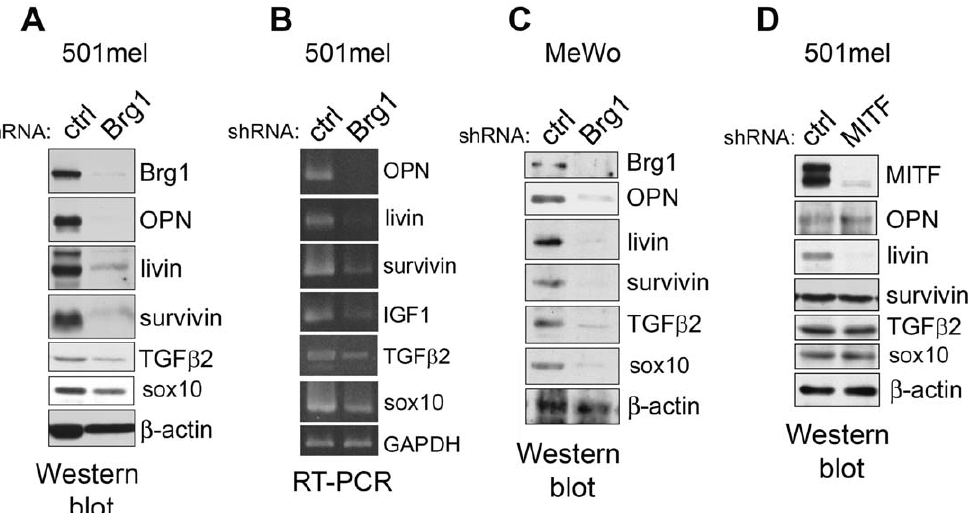
Figure 4. Several prosurvival molecules are decreased in BRG1-depleted cells and are not affected by sh-MITF. A. Decreased protein expression of OPN, livin, survivin, TGFß2 and Sox10 after BRG1 silencing in 501mel cells. B. Decreased mRNA levels for the same proteins after BRG1 silencing in 501mel cells. C. Similar decrease of expression levels for the proteins analyzed in (A) performed in MeWo cells. D. Verification that OPN, survivin, TGFß2 and Sox10 are not regulated by MITF since MITF depletion in 501mel cells did not have any effect on their protein levels. Livin alone was decreased because it is a MITF target. ß-actin used as a control was not changed in all experiments.